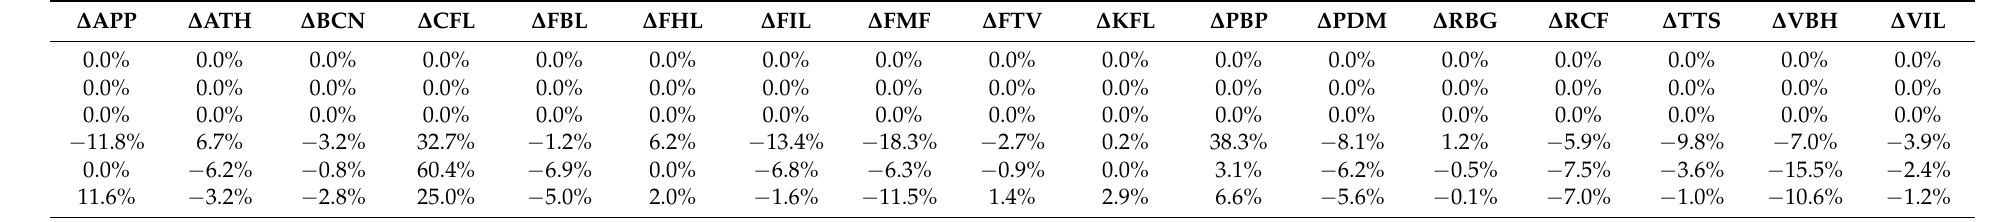
Table 18. Difference Between Mean-Variance and Semi–Variance